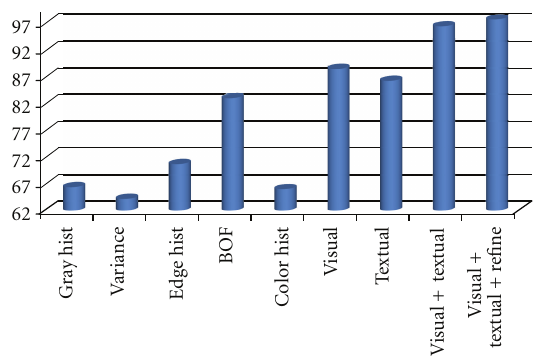
Figure 7: The recognition rates of cross-validation strategy using di ff erent features, where visual means the recognition rate using the combined feature of all visual ones, visual + textual means those using the combined textual and visual features, and visual + textual + refine means using refinement procedure after classification with the combined textual and visual